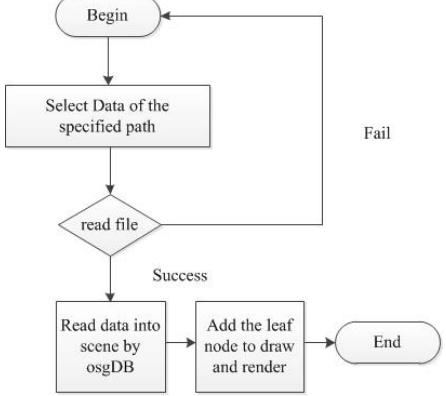
Figure 8. Step of triangulation network data visualization